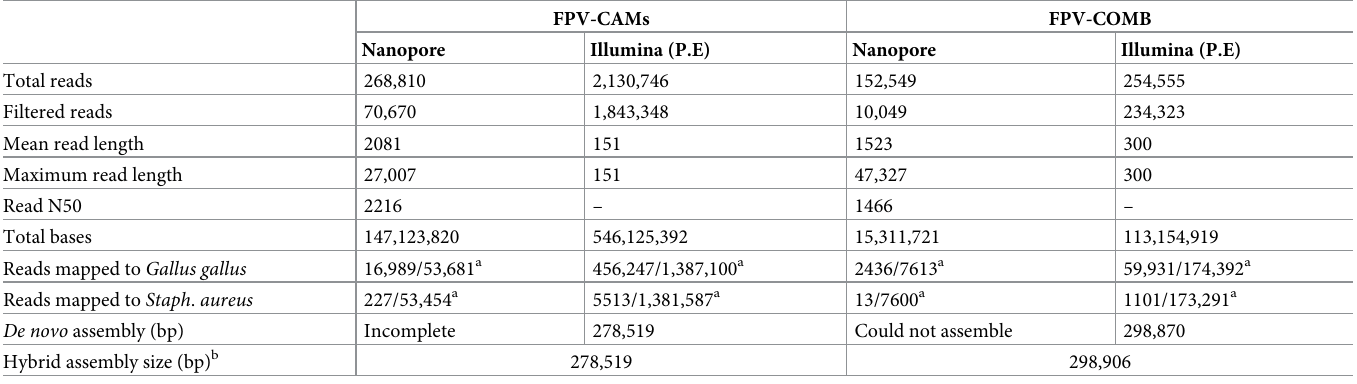
Table 1. Details of the sequencing reads before and after quality filtering and